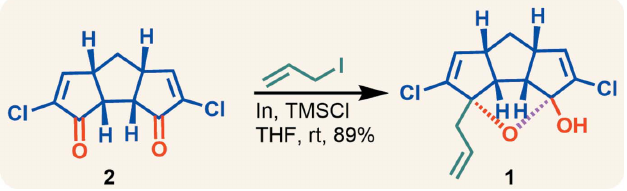
Figure 3 Synthesis scheme for 1 .